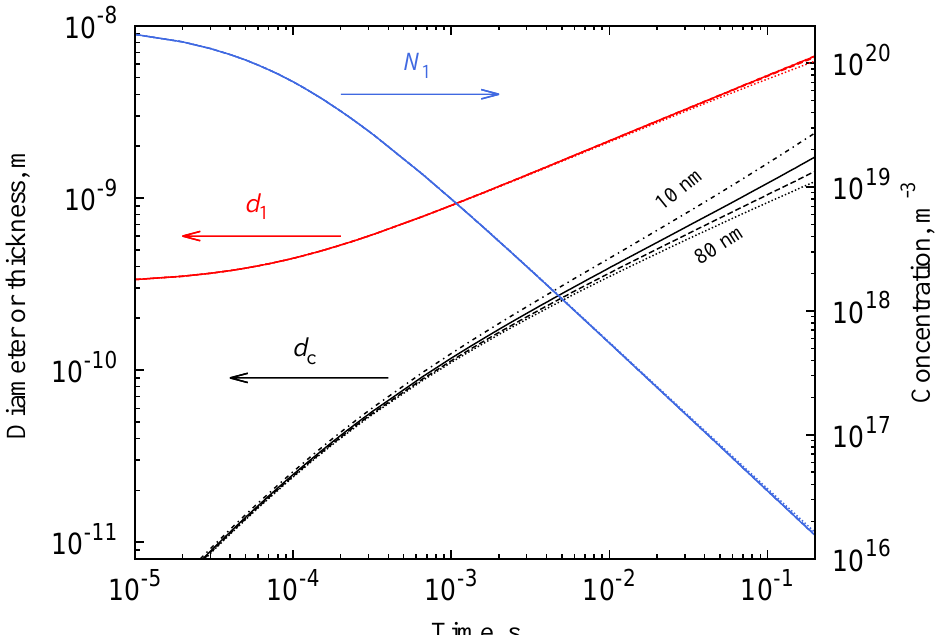
Figure 3. Simulation results for cluster concentration ( N coating thickness ( d , black), using core particle sizes of 10 nm (solid), 20 nm (dash), 40 nm c (dash-dot) and 80 nm